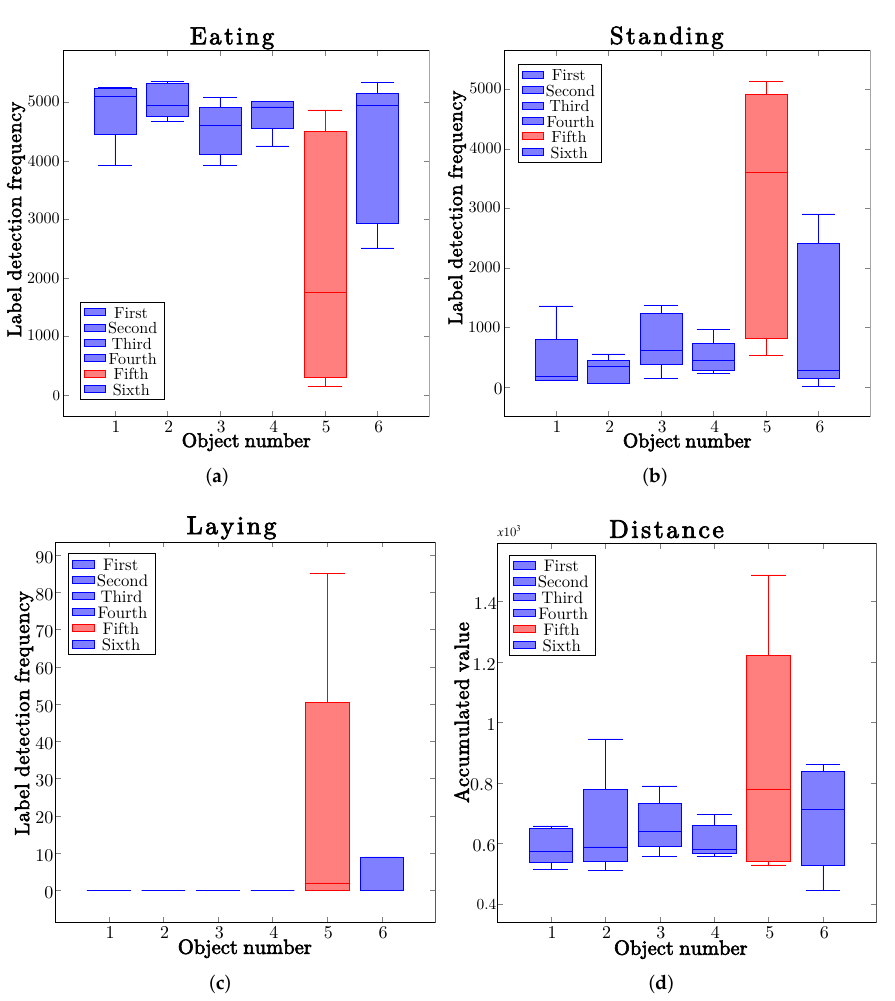
Figure 7. Label appearance frequency and cumulative object tracking. ( a ) Eating detection fre- quency. ( b ) Standing detection frequency. ( c ) Laying detection frequency. ( d ) Accummulated value for